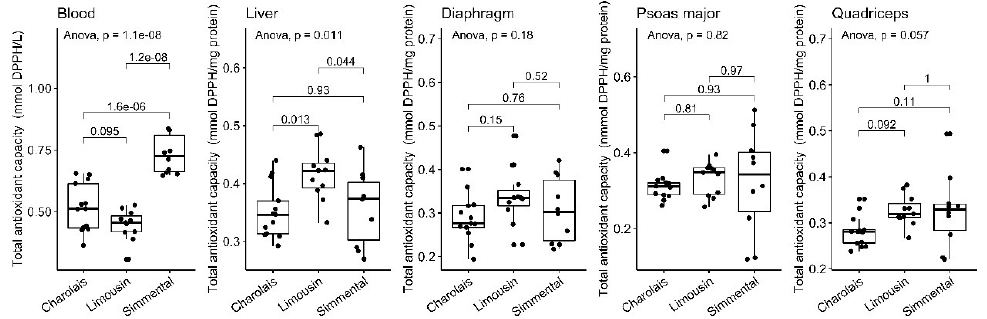
Figure 3. TAC levels in the blood, liver, diaphragm, quadriceps and psoas major of CHA, LIM and SIM cattle.